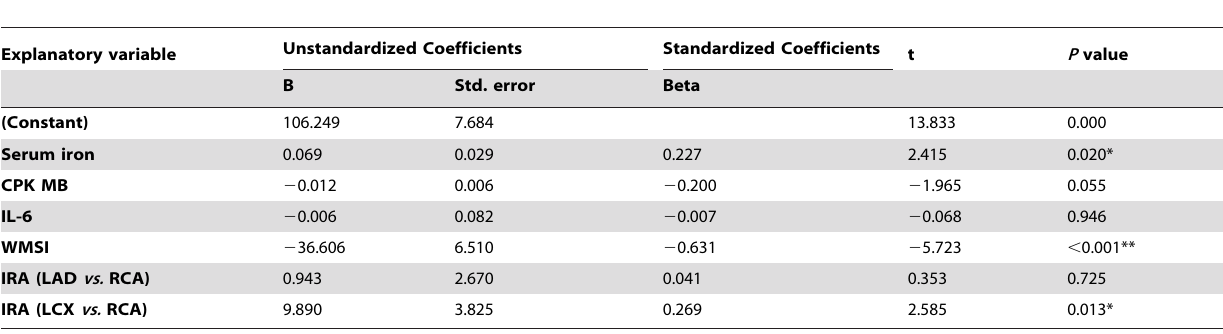
Table 5. Multiple linear regression analysis of variables associated with ejection fraction 6 months after primary angioplasty for acute myocardial